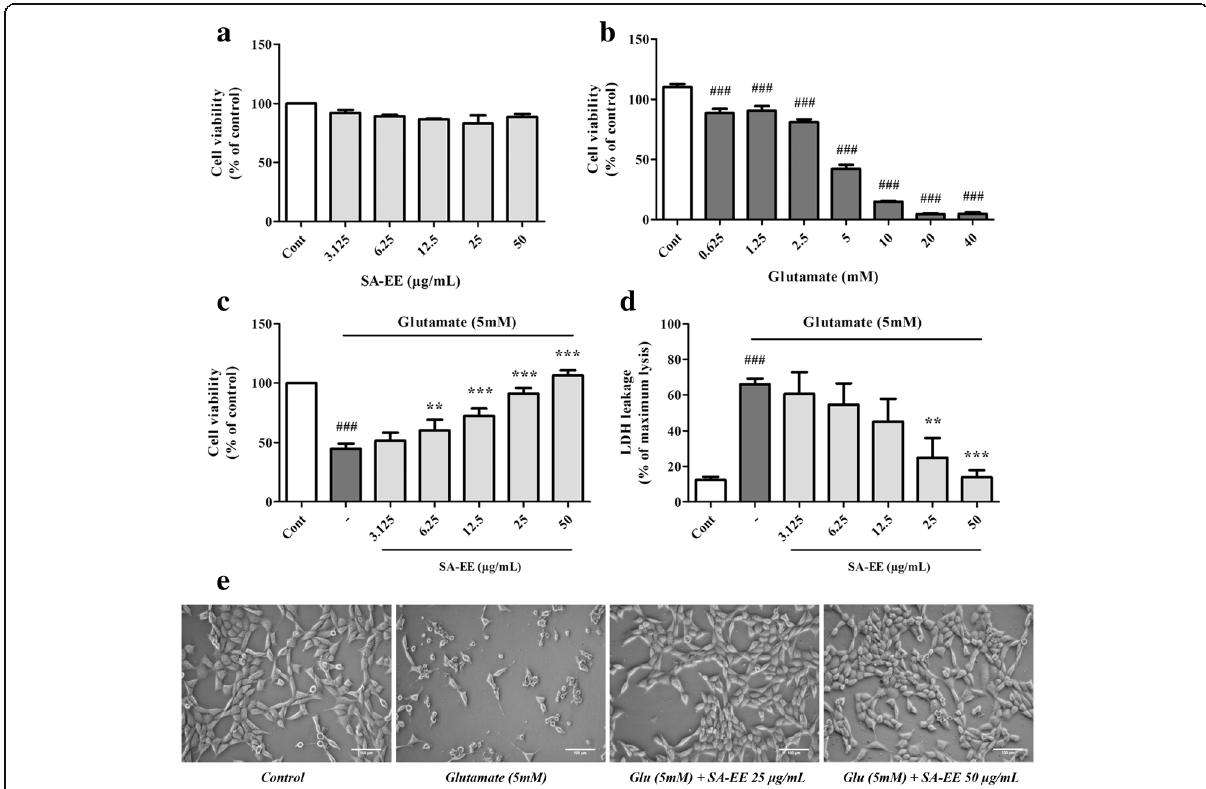
Fig. 1 Protective effect of SA-EE against glutamate-induced toxicity in HT22 cells. Toxicity of SA-EE ( a ) and glutamate ( b ) in HT22 cells was determined by MTT assay after treatment at different concentrations for 24 h. Cells were exposed to 5 mM glutamate alone or glutamate in combination with different concentrations of SA-EE for 24 h and then cell viability was measured by MTT ( c ) and LDH ( d ) assay. Cell morphology was observed under microscope at 5X magnification ( e ). All data are shown as the mean±SEM of at least three independent experiments. ### P <0.001 vs. control;